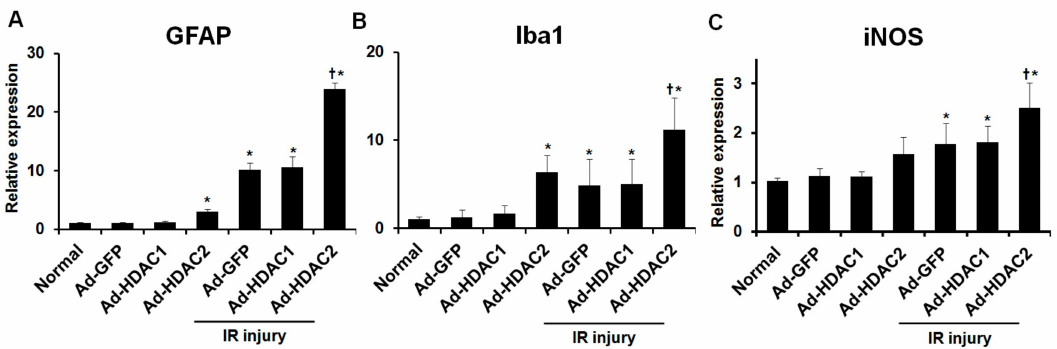
Figure 4. The e ff ect of overexpression of HDAC1 and HDAC2 on glial cells and iNOS activity in retinas. By adenoviral transduction, overexpression of HDAC2 significantly increased the expression of GFAP and Iba1 mRNA in eyes with and without IR injury compared to eyes with overexpression of GFP ( A , B ). Overexpression of HDAC2 significantly increased iNOS mRNA expression in eyes with IR injury compared to eyes with overexpression of GFP ( C ). Overexpression of HDAC1 did not significantly change the expression of GFAP, Iba1, and iNOS mRNA in eyes with and without IR injury compared to eyes with overexpression of GFP. Data were normalized to the expression of 18S-rRNA. Error bars, SD ( n = 10 retinas / group). * p < 0.001 compared to the normal group. † p < 0.001 compared to the Ad-GFP + IR injury group. Comparisons were performed using unpaired 2-tailed Student’s t